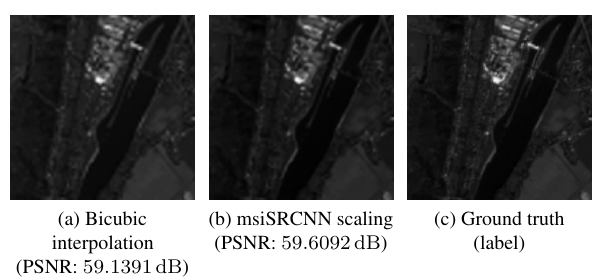
Figure 10: msiSRCNN scaling results for a scene located outside the area covered by the training and testing